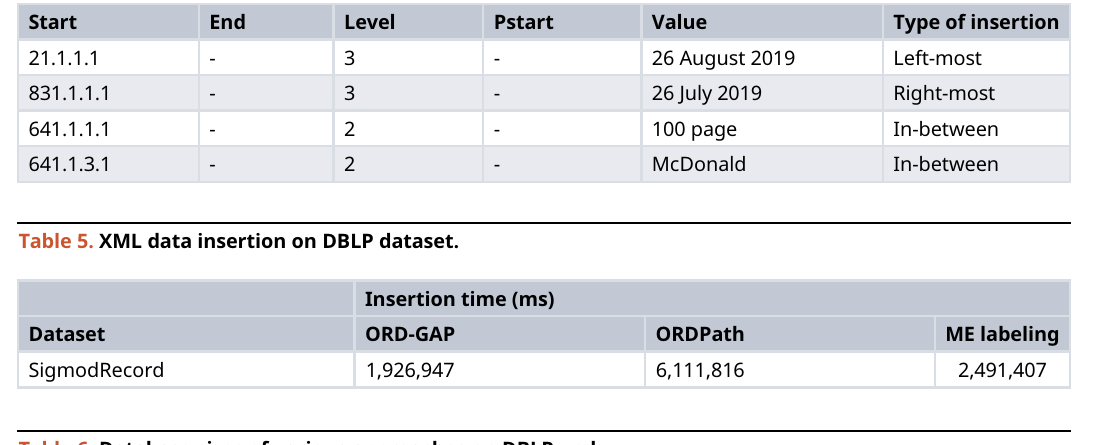
Table 6. Database sizes of various approaches on